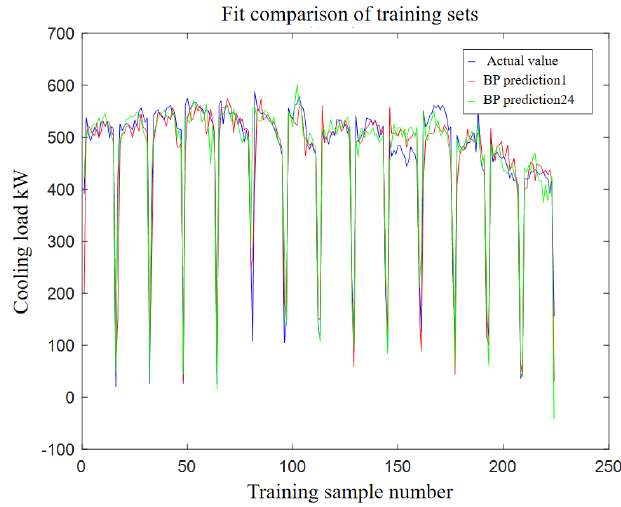
Figure 40. The fitting comparison graph of the training set.